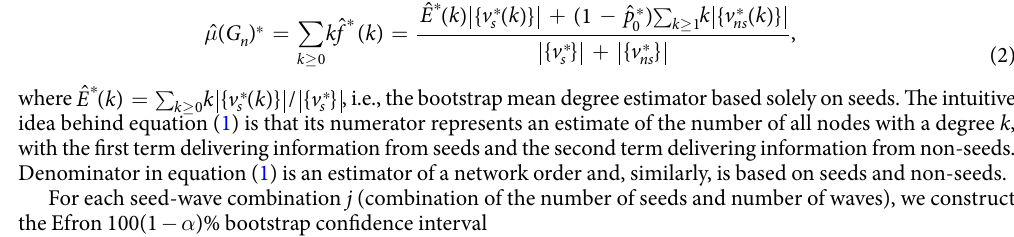
Figure 2. Histograms of bootstrap mean degrees µ ˆ ⁎ G ( ) polylogarithmic(0.1, 2) degree distribution. The 95% confidence intervals (dashed vertical lines) are for μ ( G ) = 2.42 (solid vertical